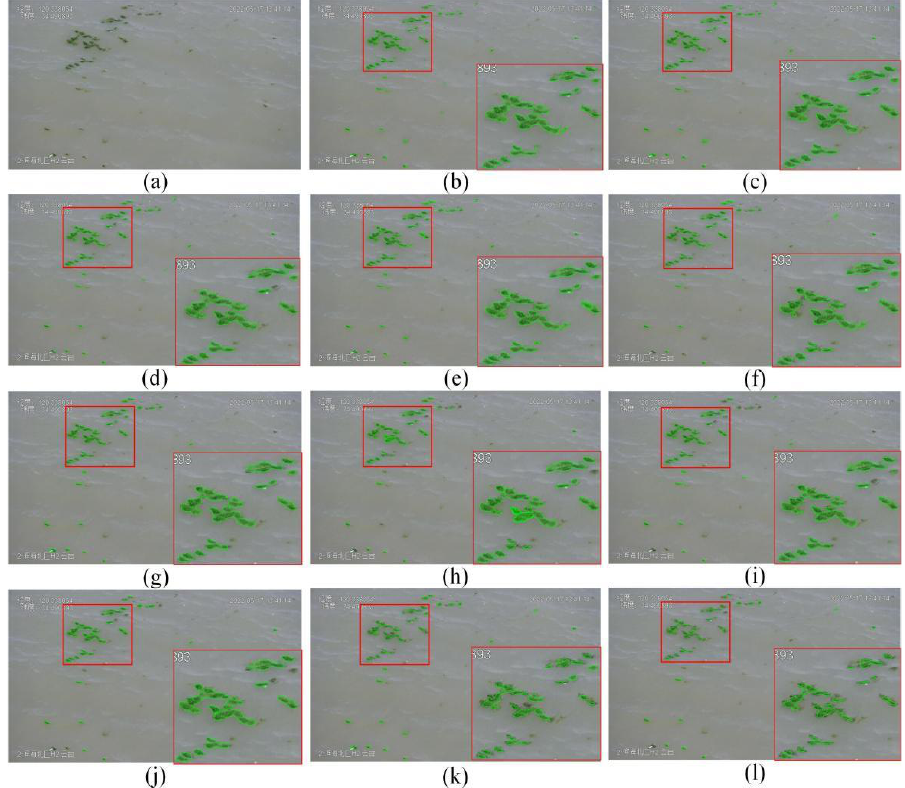
Figure 15. The visual comparison of results of different models in scene 2.